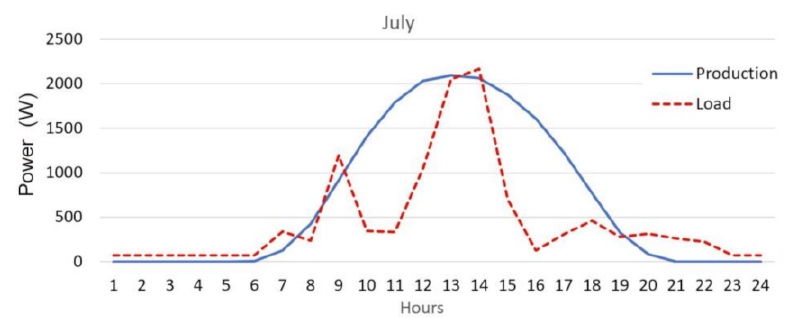
Figure 10. Load and energy production at the average daily level for July.